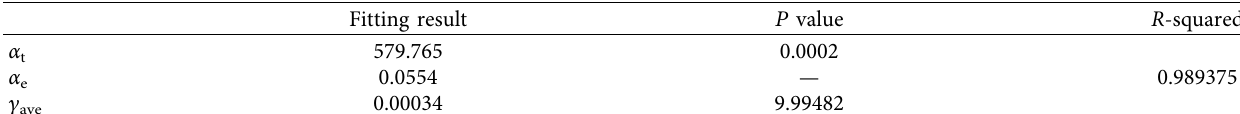
Table 4: Regression analysis results.